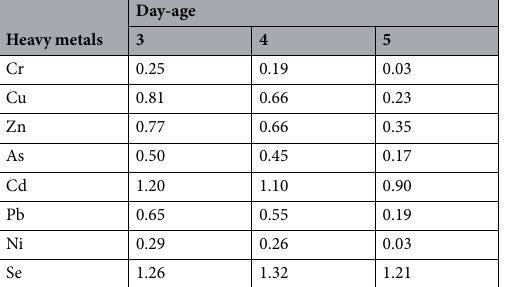
Table 1. Heavy metal bioaccumulation factors (BAF) in maggots fed with swine